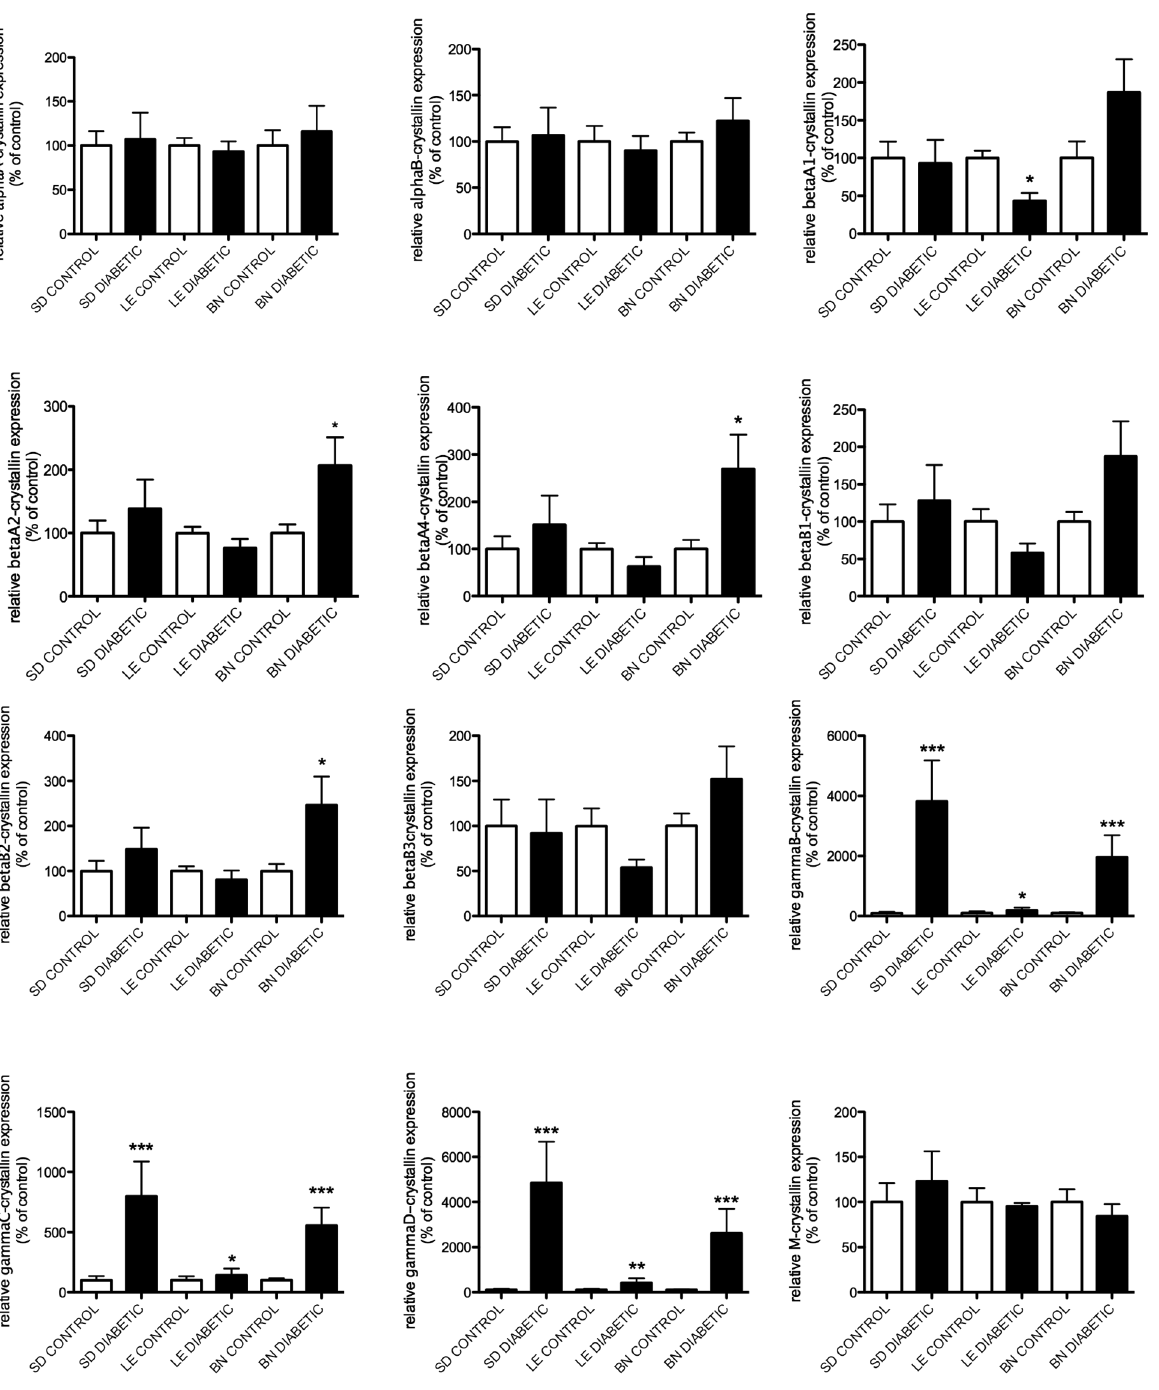
Figure 2. Gene expression analysis of crystallins after 3 months of diabetes. mRNA levels of crystallin genes (alpha-, beta- and gamma-) were assessed by Real Time PCR using gene-specific primers and probes 12 weeks after the onset of diabetes in Sprague Dawley (SD), Long Evans (LE) and Brown Norway (BN) rats. A representative graphic representation of the corresponding quantification is presented for alphaA-, alphaB-, betaA1-, betaA2-, betaA4-, betaB1-, betaB2-, betaB3-, gammaB-, gammaC-crystallin, gammaD- and M-crystallin mRNA respectively (A-L). *Significantly different from control [ P , 0.05]. doi:10.1371/journal.pone.0082520.g002 published the effect of diabetes on crystallins in the SD rat strain, crystallin protein levels were unaltered in the LE and BN diabetic rats compared to their control littermates. At 12 weeks, all three few samples were used and no statistical analysis was performed subgroups of crystallin proteins were significantly upregulated in for this rat strain, but similar trends were observed and support LE and BN diabetic rats. Since we already extensively studied and our previously published results [14]. Furthermore, detailed